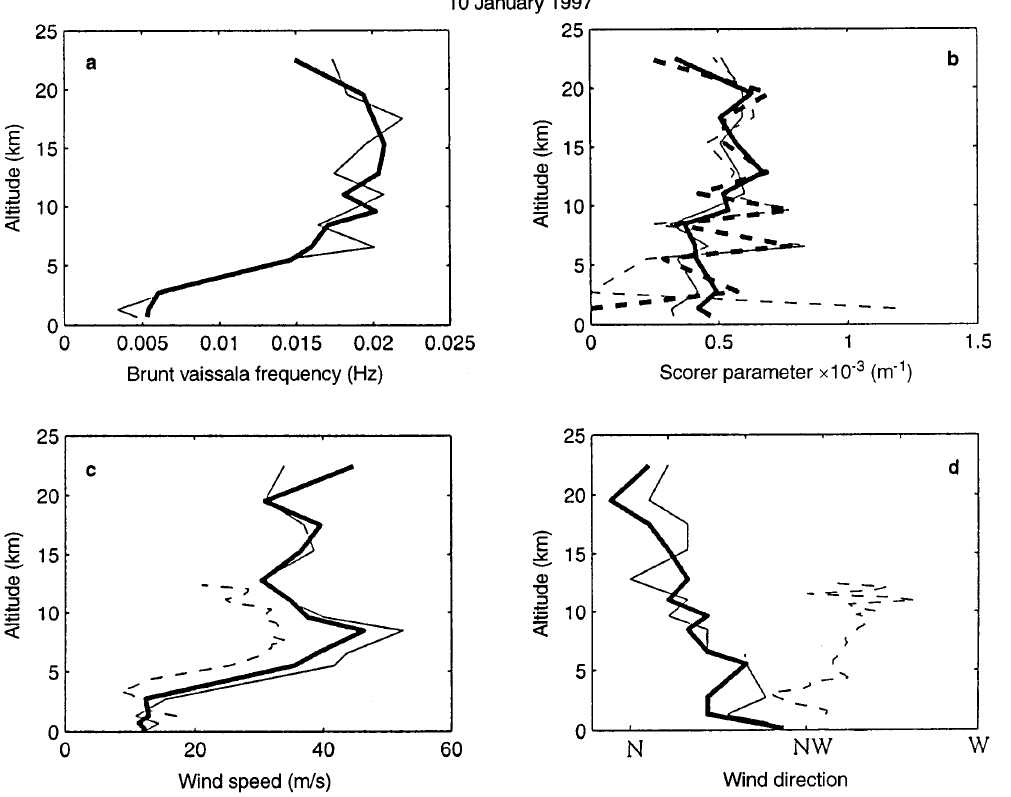
Fig. 10. Profiles for 10 January for 0 UT ( thin line ) and 12 UT ( thick line ) a Brunt Vaissala frequency from radiosonde from Bodo. b Scorer parameter from radiosonde from Bodo ( solid line : simplified, dashed: full expression, see text). c Wind intensity from radiosonde from Bodo